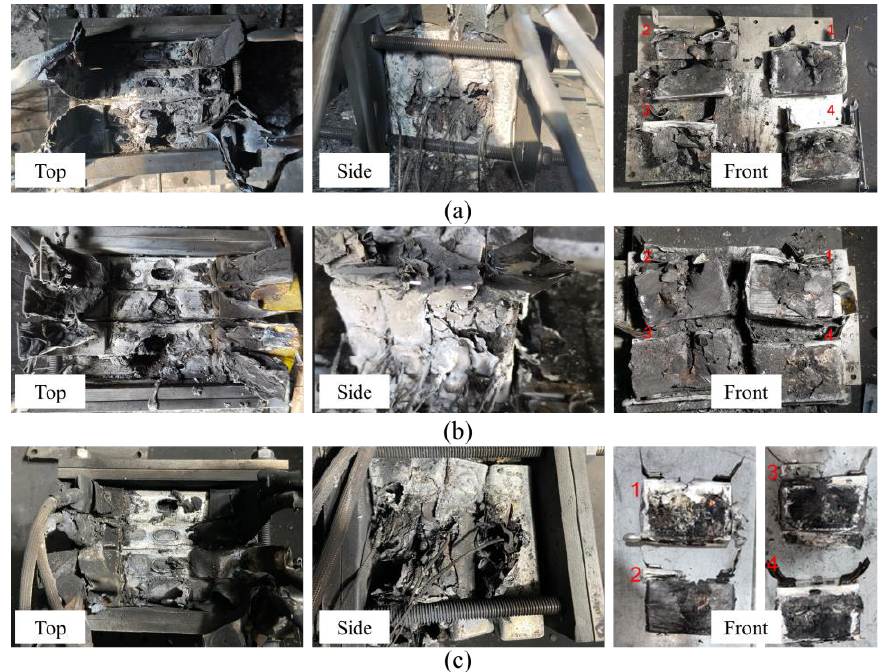
Figure 14. TRP wreckage with different trigger methods. ( a ) Nail penetration; ( b ) Side heating; ( c ) Overcharge.